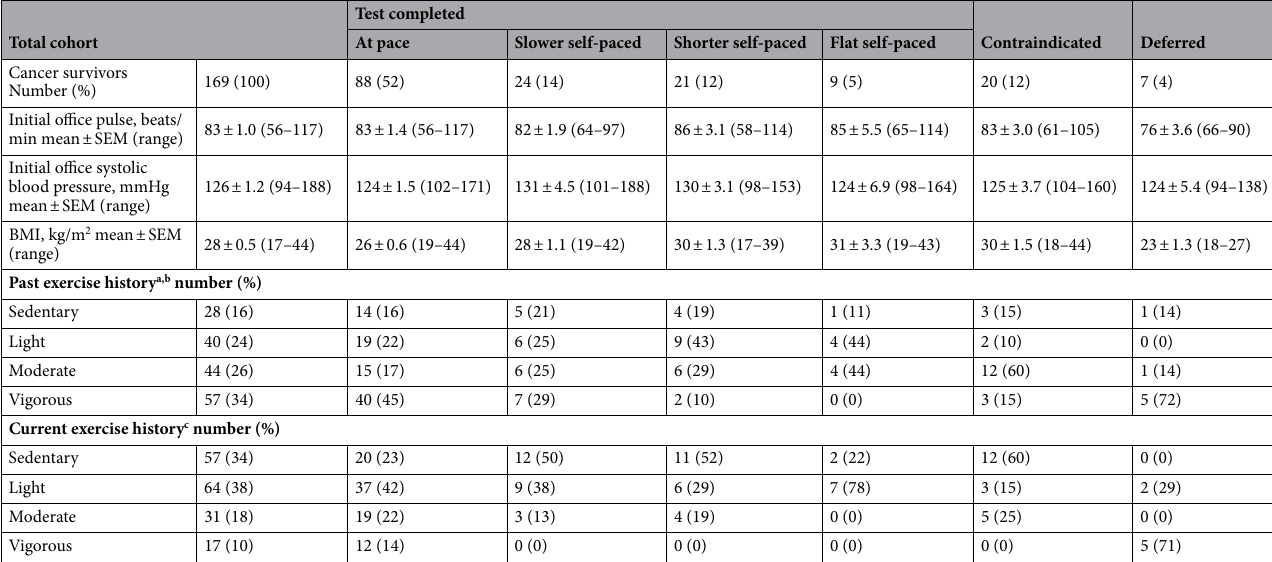
Table 2. Fitness correlates with exercise history. a Past exercise Hx: at pace vs. shorter self-paced p = 0.0191, chi square, two-tailed. At pace vs. flat self-paced p = 0.0078, Fisher’s exact, two-tailed. At pace vs. contraindicated p = 0.0007, chi square, two-tailed. b Past exercise vs. current exercise Hx: total cohort p = 0.0000, at pace p = 0.0000, chi square, two-tailed. Slower self-paced p = 0.0081, contraindicated p = 0.0042, Fisher’s exact, two- tailed. c Current exercise Hx: at pace vs. slower self-paced p = 0.0304, at pace vs. shorter self-paced p = 0.0355,